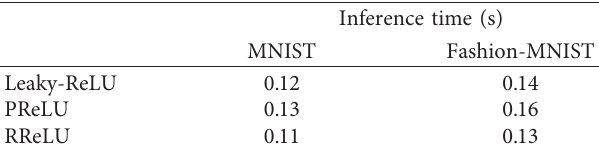
Table 2: The inference time of the N-D 2 NN model using three ReLU activation functions for the MNIST dataset and fashion- MNIST